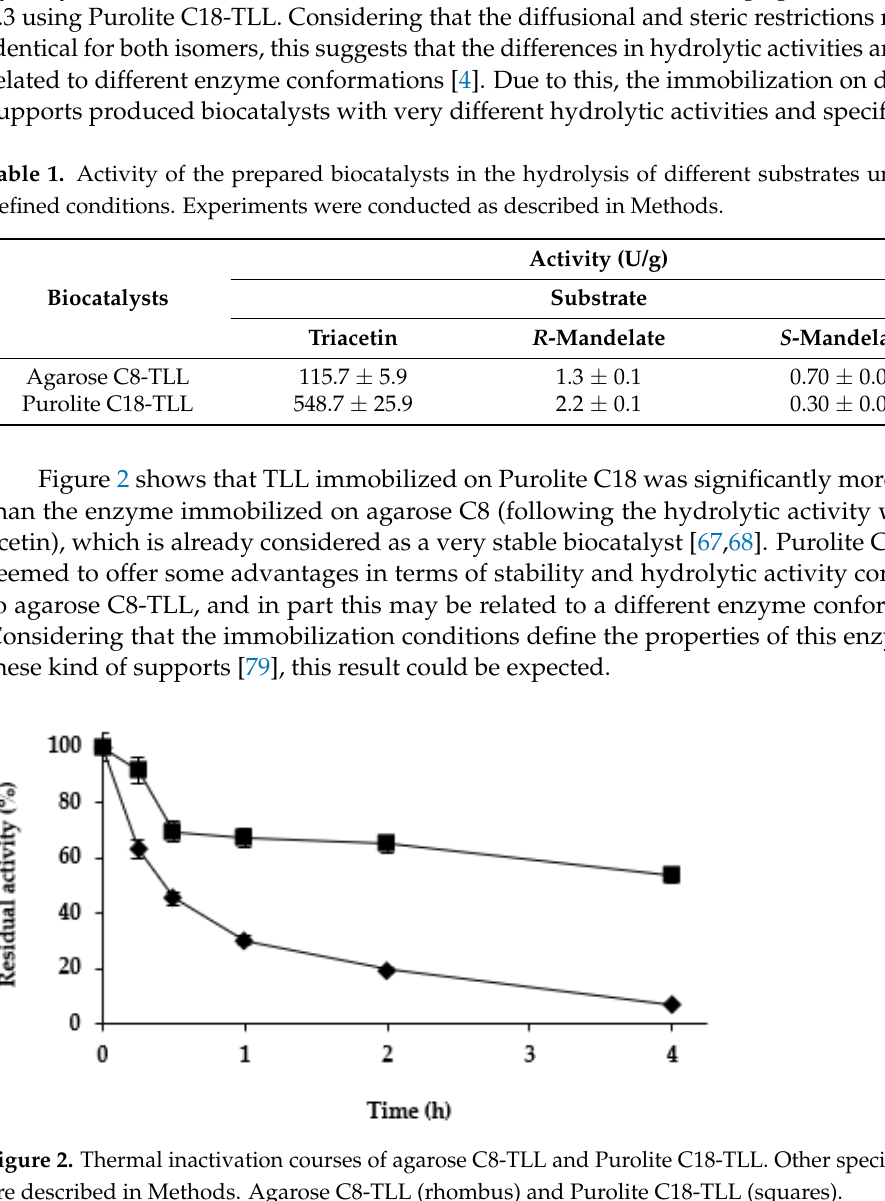
Table 1. Activity of the prepared biocatalysts in the hydrolysis of different substrates under the defined conditions. Experiments were conducted as described in Methods.